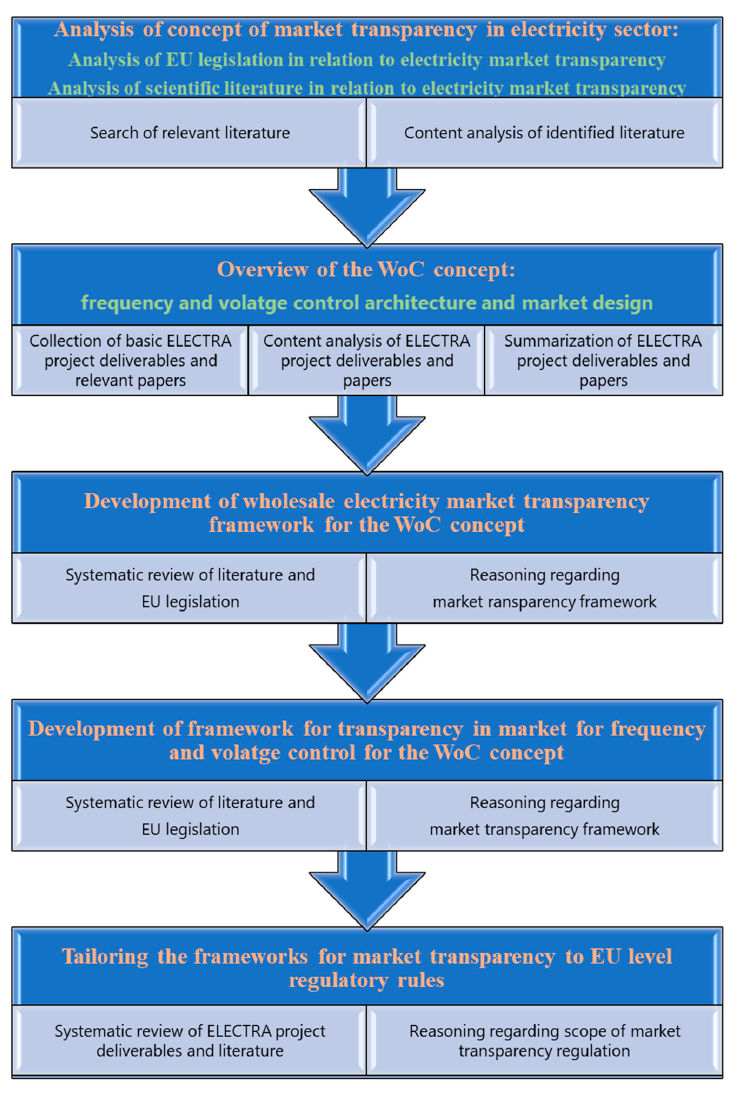
Figure 1. Logical scheme of research performance and related research methods.